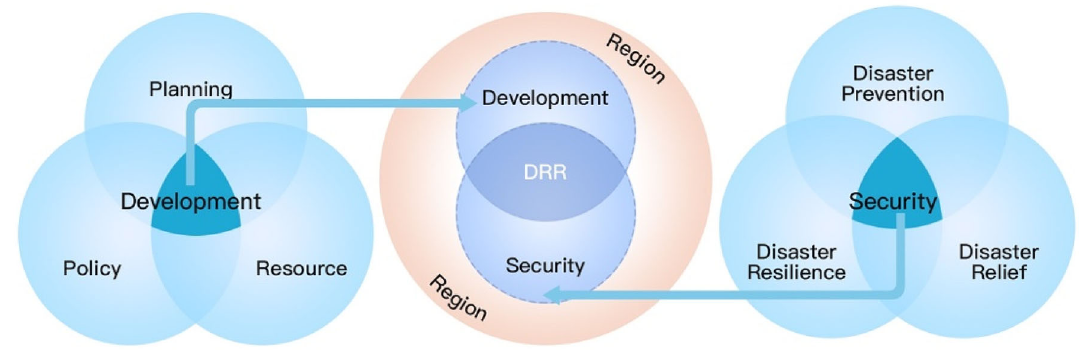
Fig. 4 Synergetic paradigm for disaster risk governance and sustainable development. Source Adapted from Shi